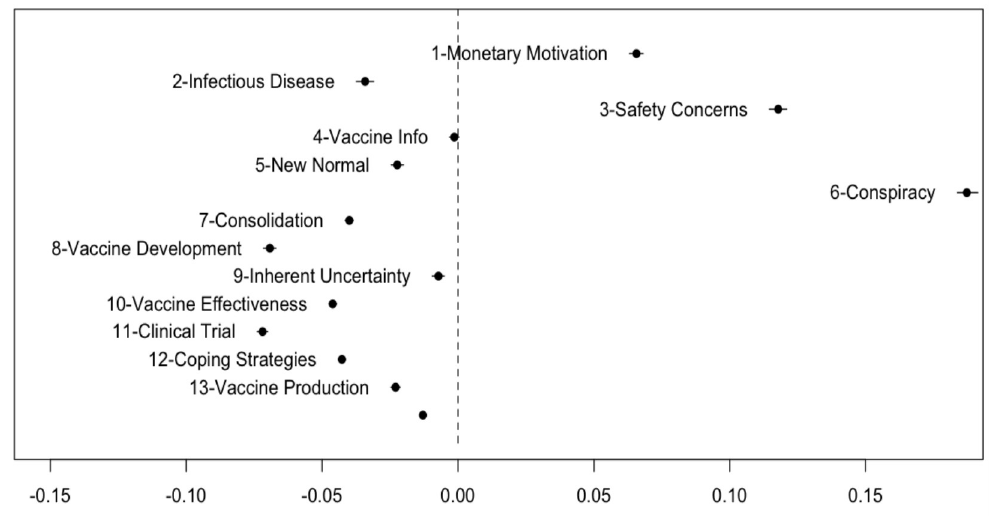
Fig 5. Difference in topical prevalence. Moving to the left means positive- and moving to the right means negative vaccine Twitter discourse.